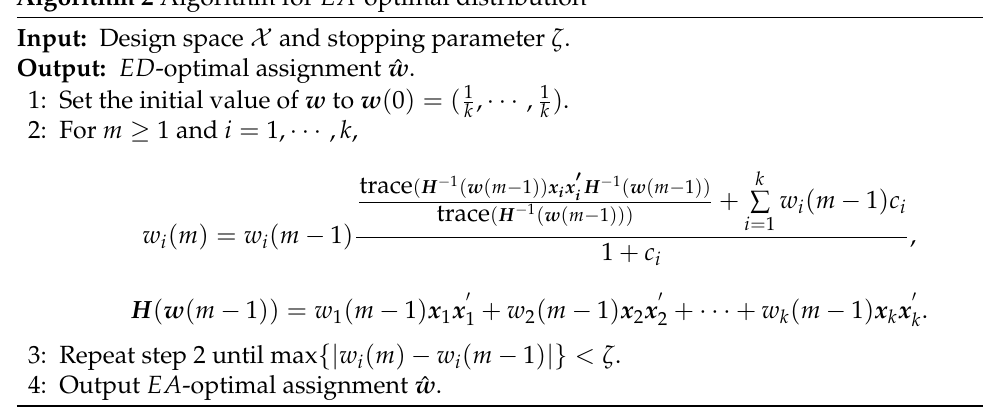
Algorithm 2 Algorithm for EA -optimal